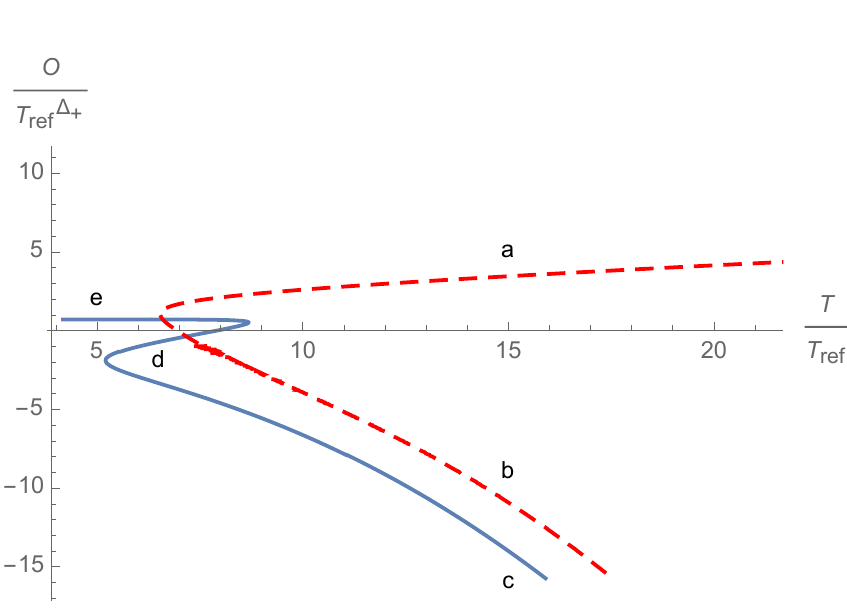
Figure 27 . Comparison of the VeVs of the scalar operator on the various black hole branches in region I (blue, solid) and region II (red, dashed). Latin letters label the separate branches shown in (cid:12)gure